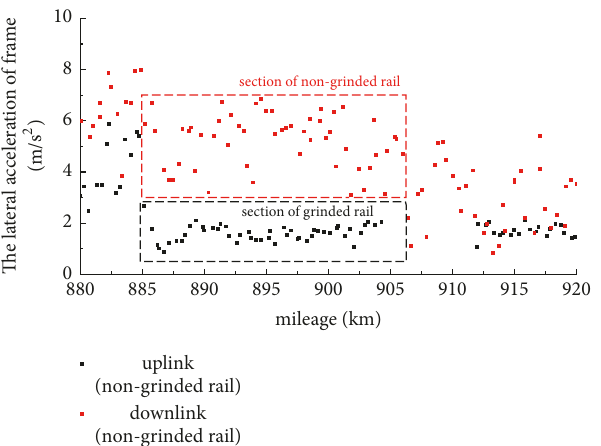
Figure 6: The lateral acceleration of bogie frame in the test section.